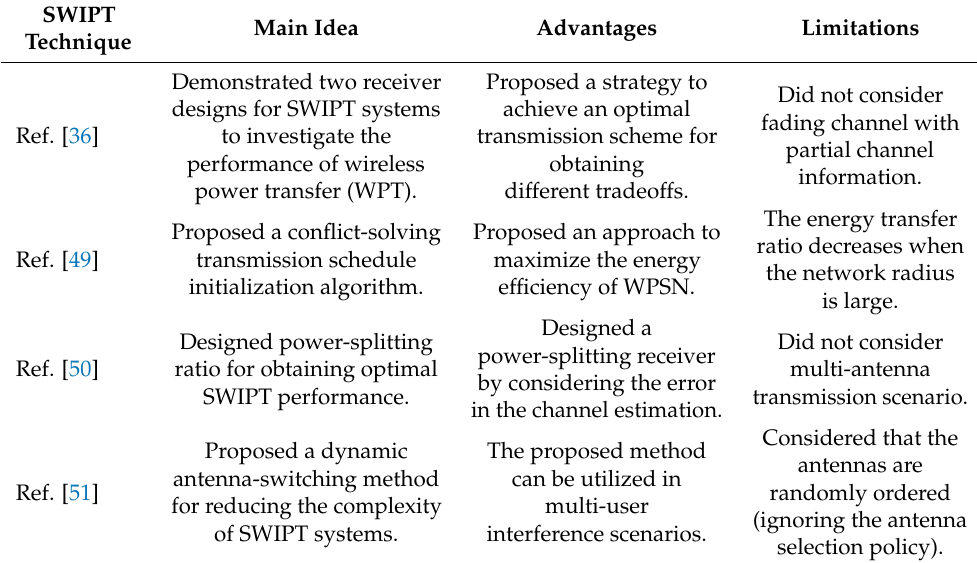
Table 7. Comparison of existing SWIPT techniques in terms of the main idea, advantages, and limitations.